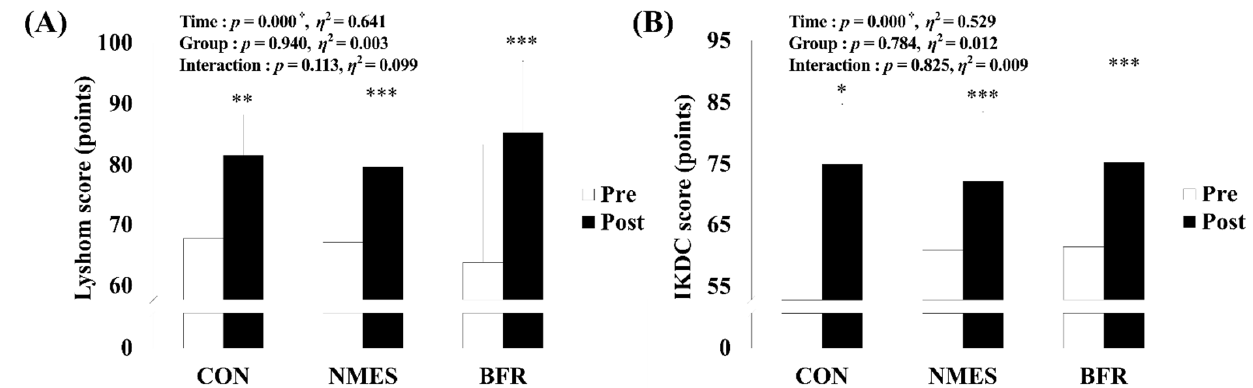
Figure 3. Changes in Lysholm score and IKDC subjective score via rehabilitation intervention in each group. ( A ) Change in Lysholm’s score. ( B ) Change in IKDC’s subjective score. CON, control group; NMES, neuromuscular electrical stimulation group; BFR, blood flow restriction group; IKDC, International Knee Documentation Committee. Significant interaction or main effect: † p < 0.05; Significant difference in each group via rehabilitation intervention: * p < 0.05, ** p < 0.01, *** p < 0.001.